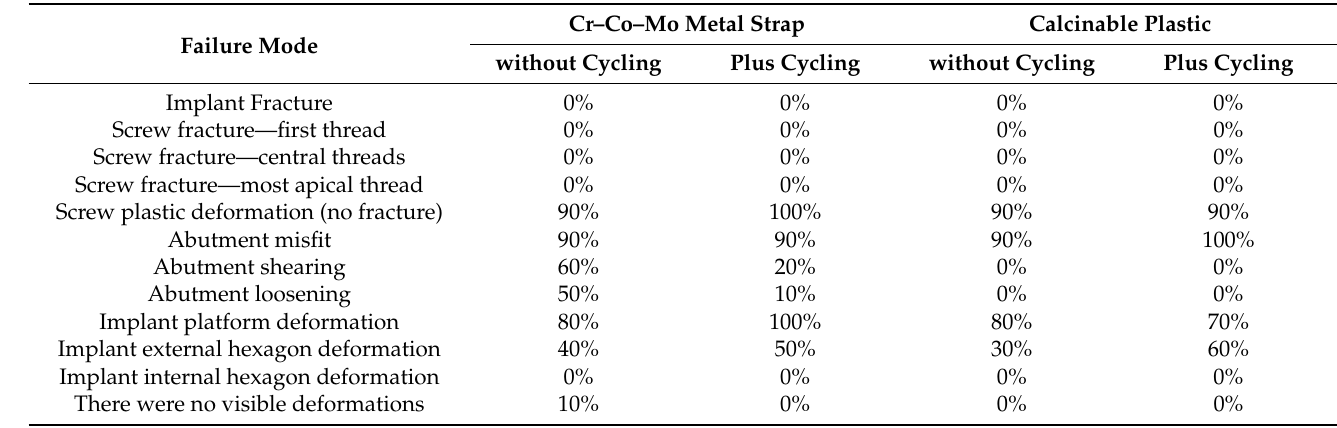
Table 3. Relative frequency (%) of failure modes observed in the implant/abutment according to the type of abutment and presence of mechanical cycle.